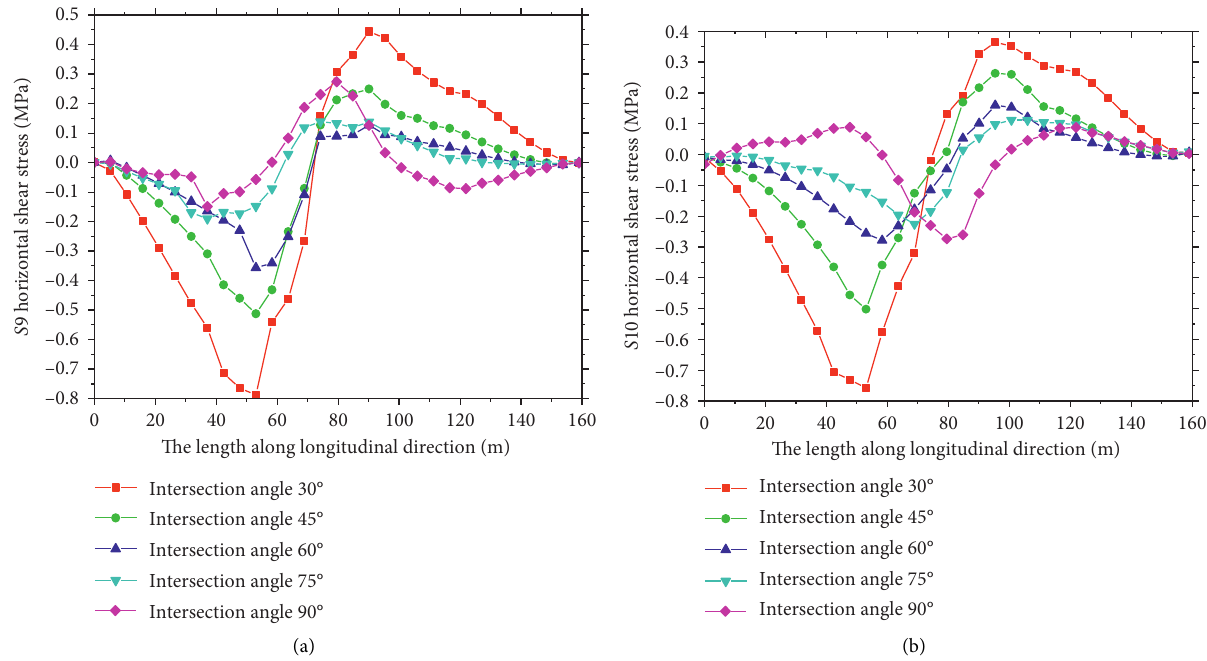
Figure 12: Shear stress in horizontal direction with different intersection angle. (a) The shear stress in horizontal direction of surveying line 9. (b) The shear stress in horizontal direction of surveying line